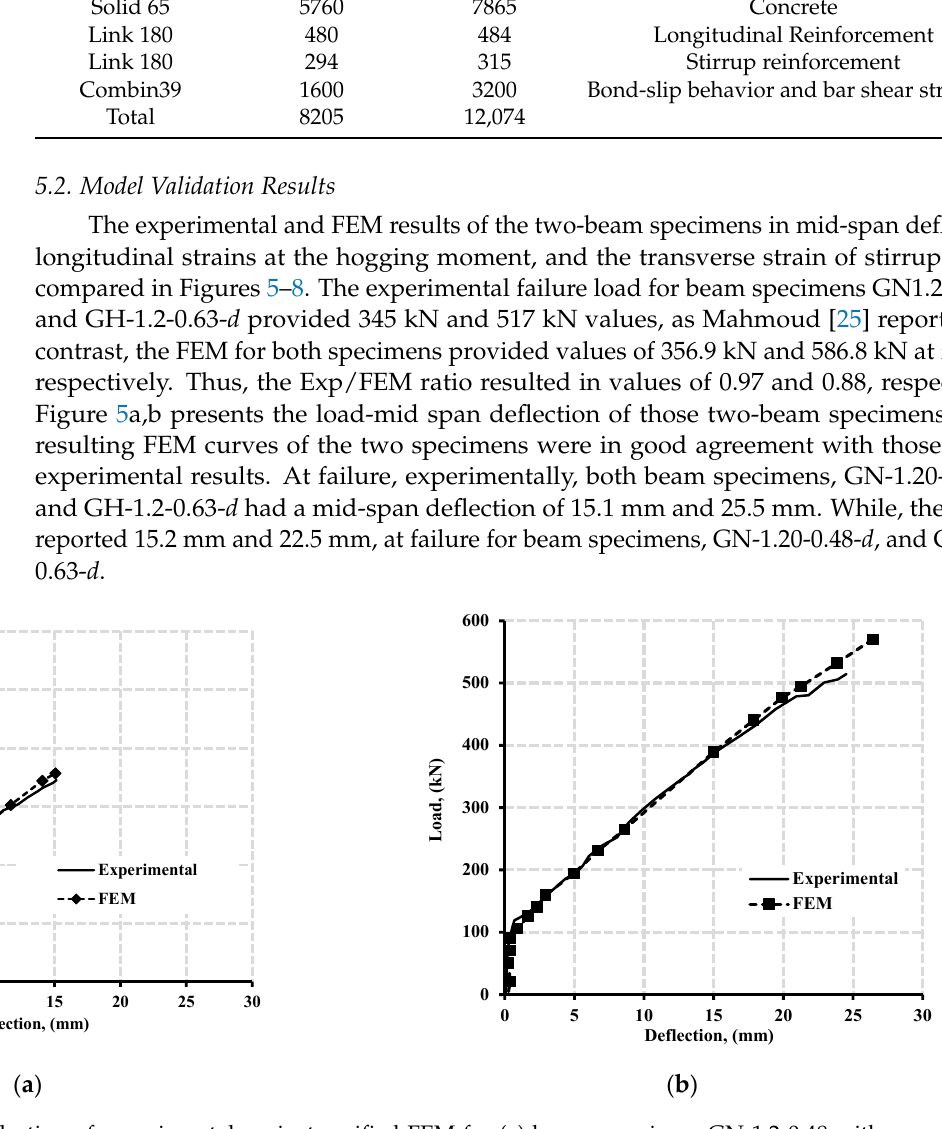
Figure 5. Mid ‐ span deflection of experimental against verified FEM for ( a ) beams specimen GN ‐ 1.2 ‐ 0.48 with normal concrete strength (43 MPa), and ( b ) beams specimen GH ‐ 1.2 ‐ 0.63 with high concrete strength (80 MPa).